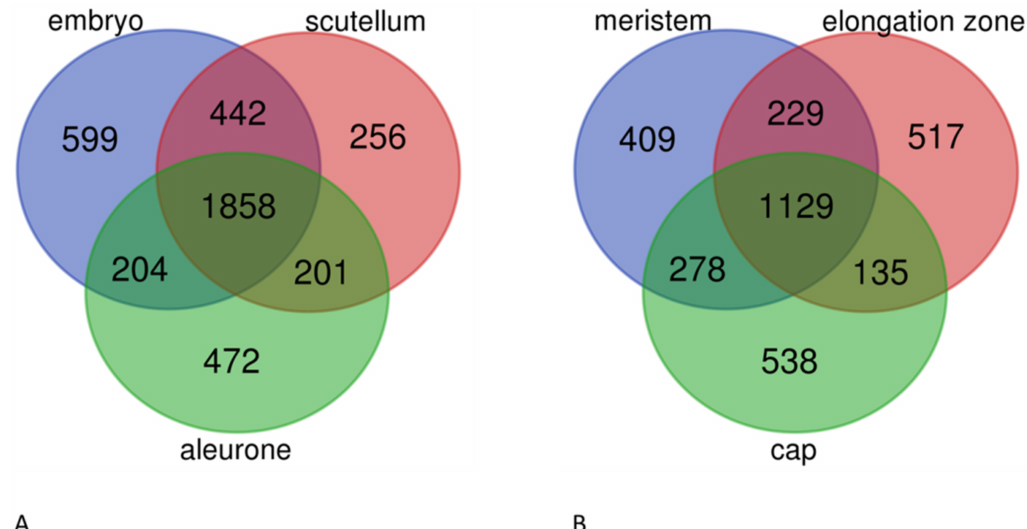
Figure 5. Number of co-expressed and uniquely expressed lncRNA loci in different parts of grain ( A ) and root ( B ).